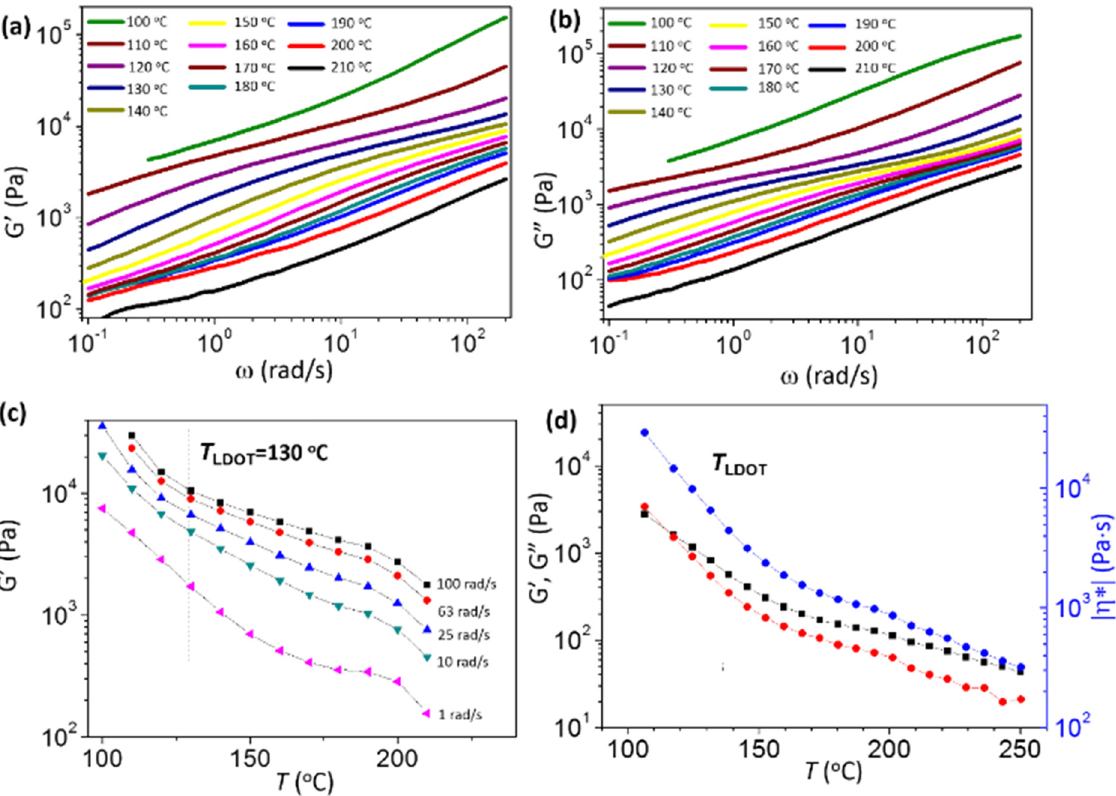
Figure 3: ( a ) Storage modulus ( G ′ ) and ( b ) loss modulus ( G ″ ) versus angular frequency ( ω ) from dynamic oscillation at a fi xed temperature range from 100°C to 210°C with the interval of temperature at 1°C for ( S 15.4 - 0.48 - B 16.7 ) 3 , ( c ) isochronal plots of G ′ versus temperature ( T ) for ( S 15.4 - 0.48 - B 16.7 ) ( d ) temperature dependence of the storage modulus ( G ′ ) , loss modulus ( G ″ ) , and complex viscosity (| η * |) obtained at 3 , the strain amplitude 1% and a signal angular frequency 1 rad · s − 1 during the cooling of ( S 15.4 - 0.48 - B 16.7 ) 3